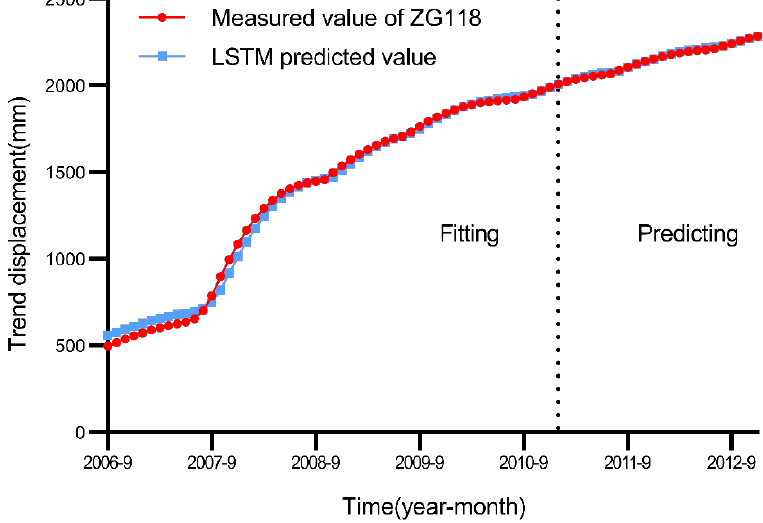
Figure 11. Fitting and predicting results of trend displacement of ZG118.